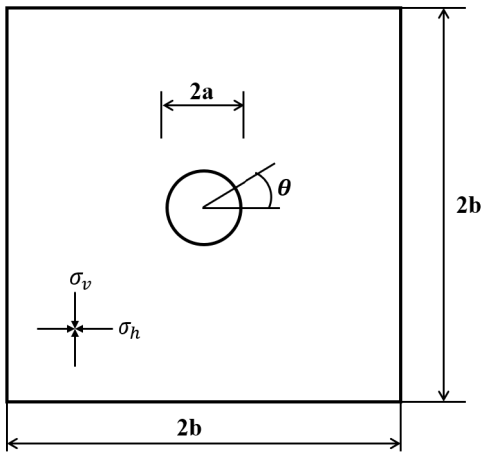
Figure 3. Sketch of the thermal-mechanical model.